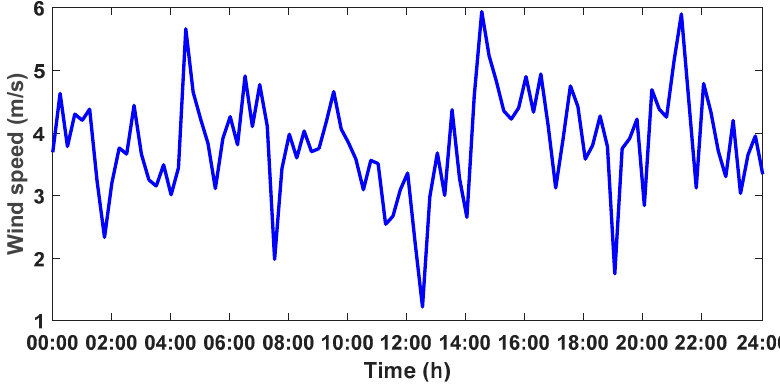
Figure 11. The outside wind speed of the CSG on 26 January 2018.